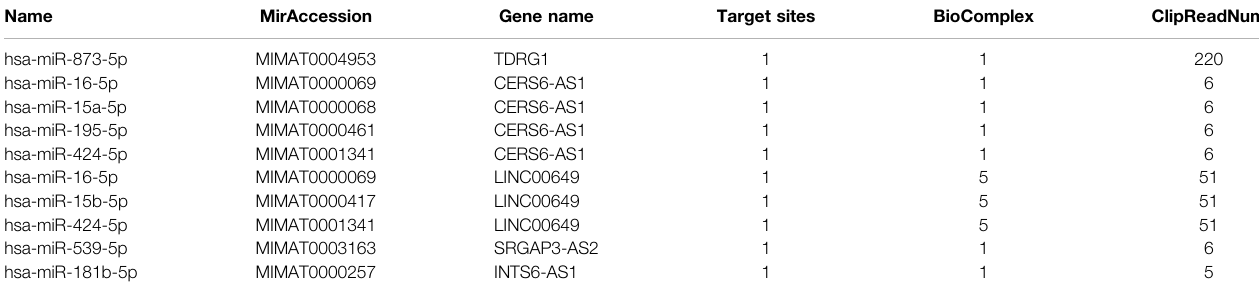
TABLE 3 | Targeted micro RNAs predicted by differentially expressed long non-coding RNAs using the integrated data.